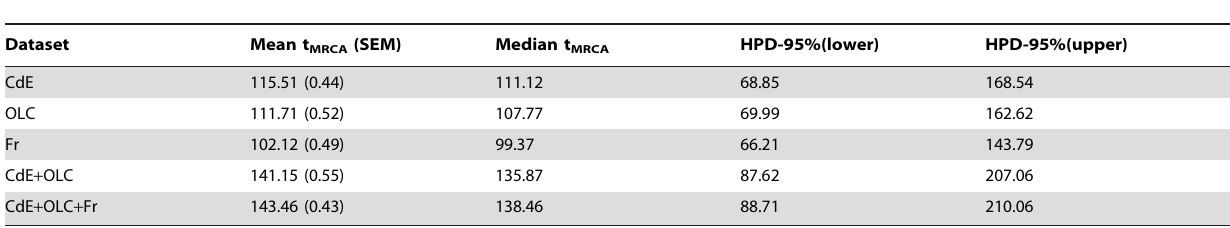
Table 4. Summary for t MCRA estimations using the NS5B region.